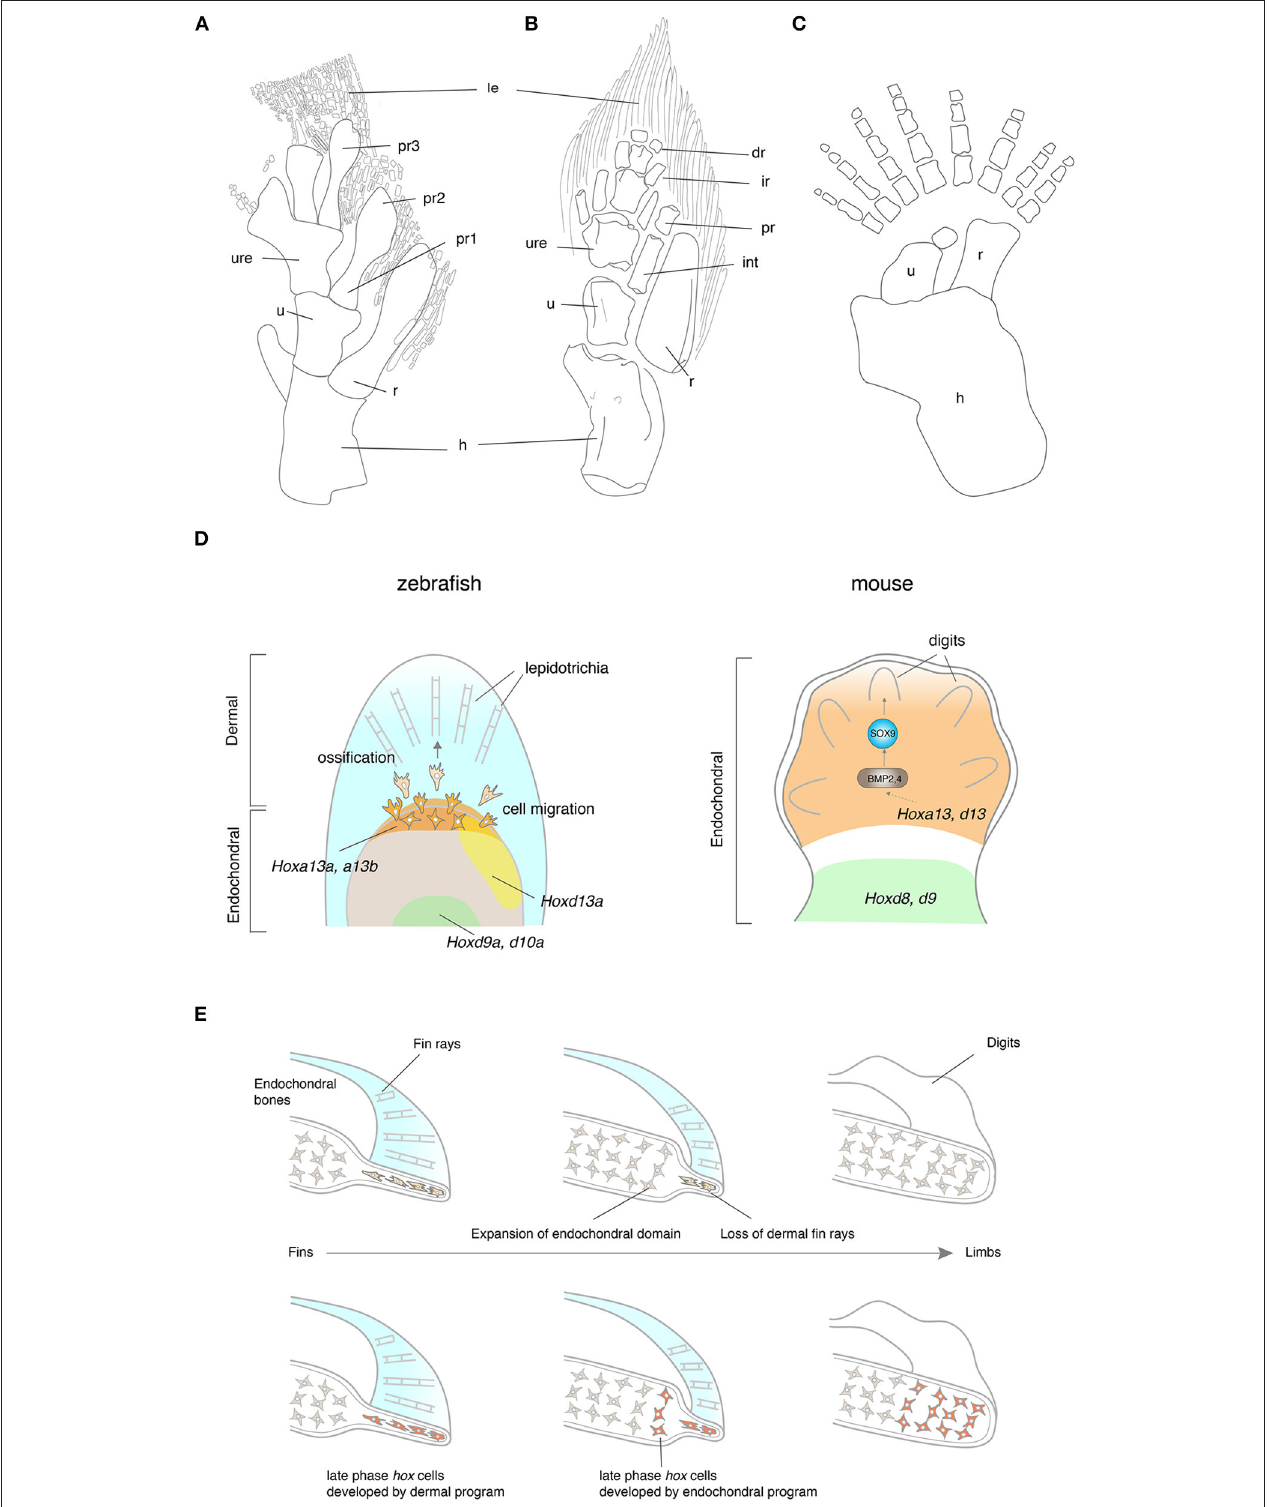
FIGURE 3 | The fin-to-limb transition and their developmental basis. (A–C) The pectoral fins and limbs of Eusthenopteron (A) , Tiktaalik (B) , and Acanthostega (C) . Note that Eusthenopteron and Tiktaalik possess distal fin rays with the endochondral skeletons. (D) The developmental mechanisms of fin rays and digits. In zebrafish,